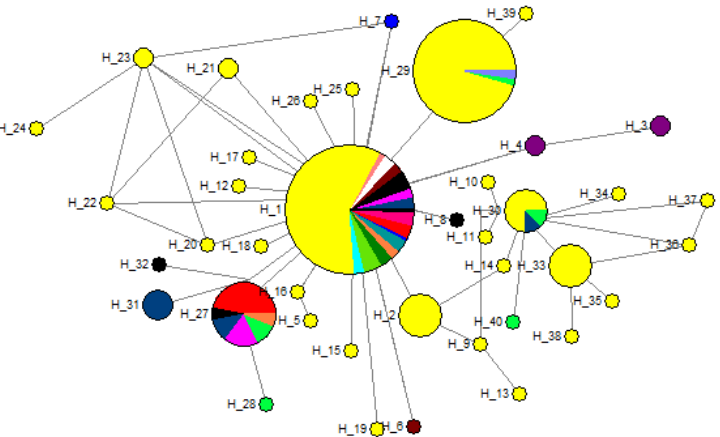
Figure 2. Median joining network of rDNA haplotype of B. sorokiniana populations. The size of the circle is related with the frequency of haplotypes and different colours indicate the proportion of individual samples in different populations within the study area. Table 2. AMOVA of ITS, GAPDH and TEF-1 α sequences for geographic and haplogroups of B. sorokiniana